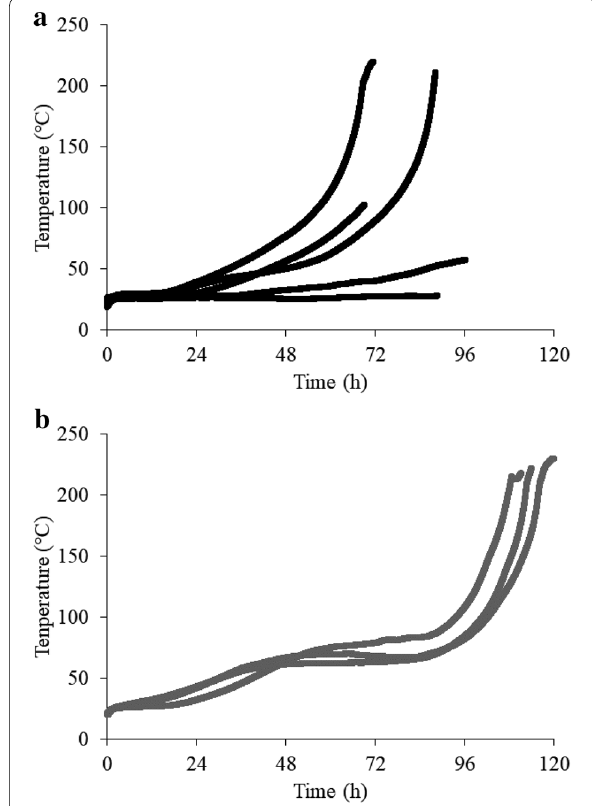
Fig. 9 Self-heating with different moisture contents: a 10%w.b., b